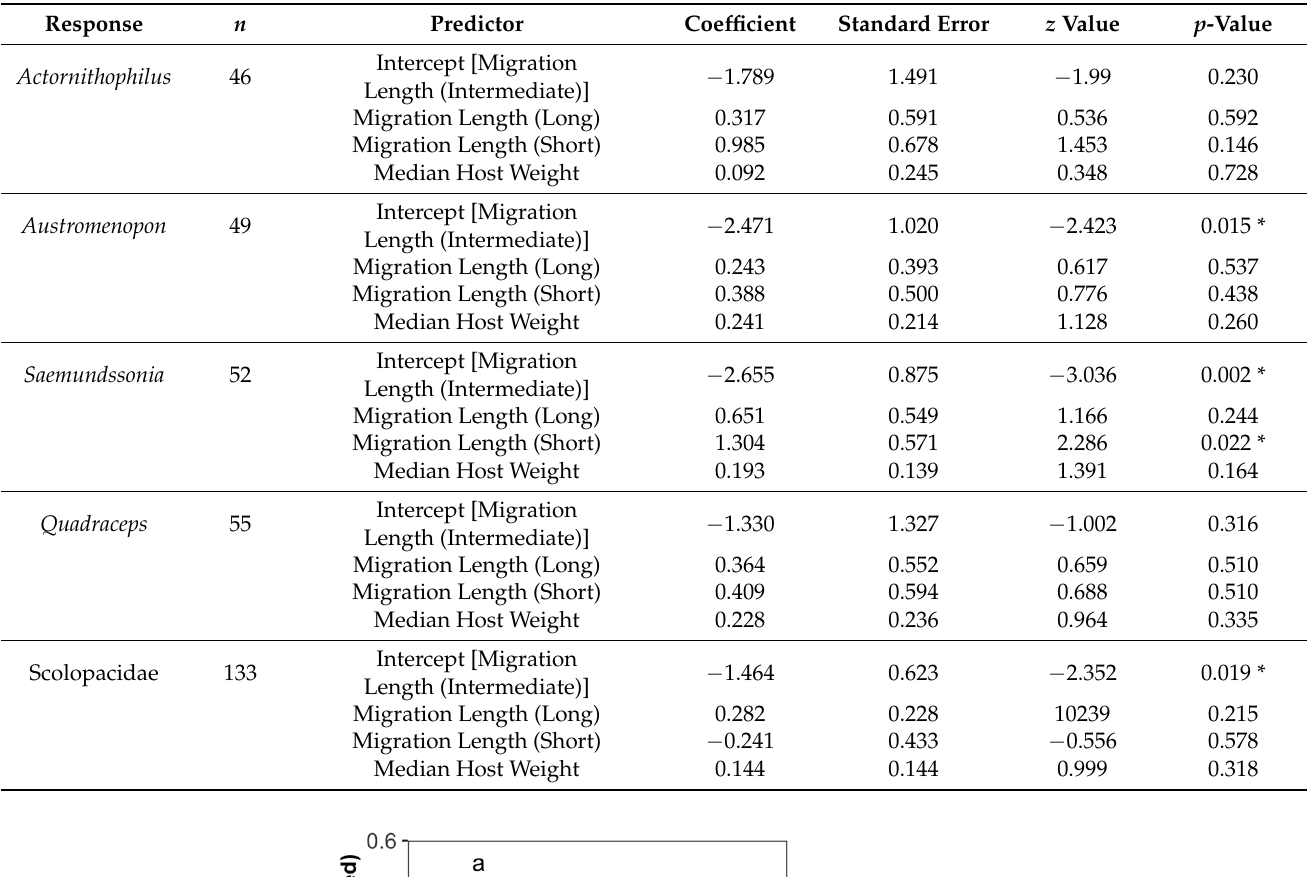
Table 12. Summary of GLMM (beta distribution and logit-link function) of the effects migration length and host weight on the prevalence of lice. An asterisk (*) designates the only statistically significant value.